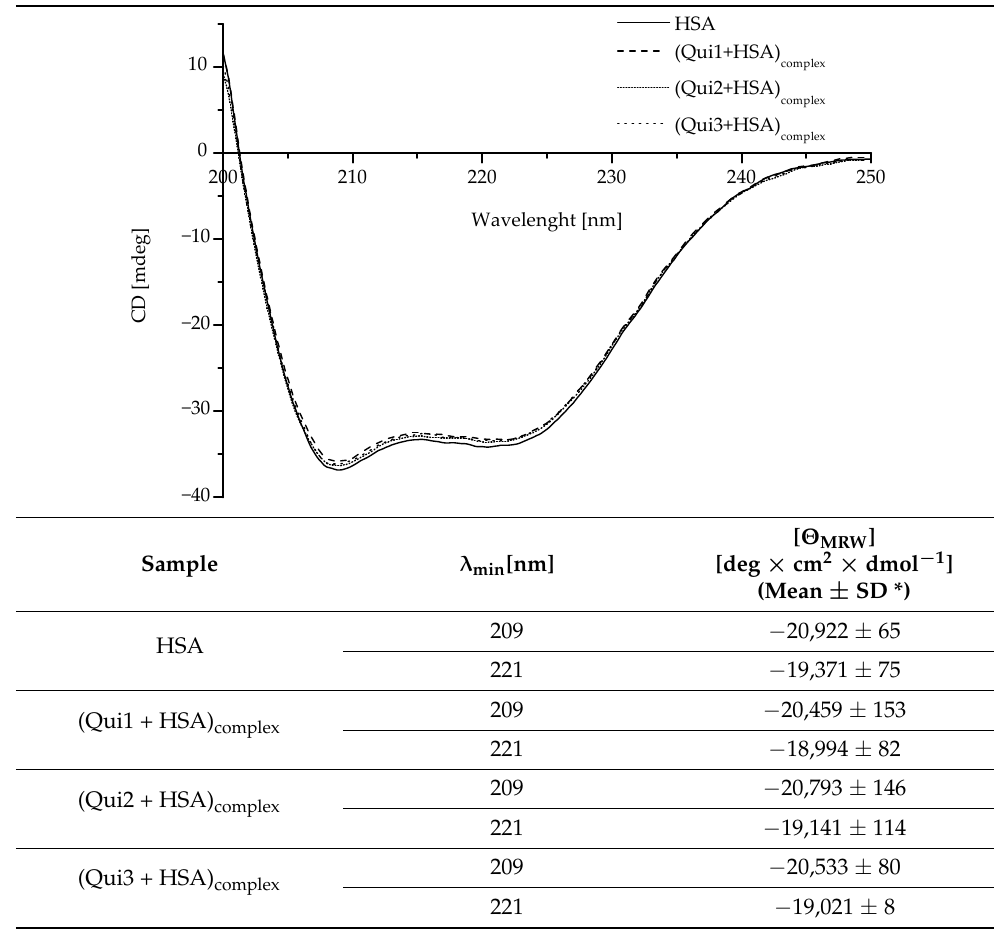
Table 3. The CD spectra and the values of the mean residue ellipticity [ Θ MRW ] of HSA, both in the absence (HSA) and presence of ligands ((Qui1 + HSA) complex , (Qui2 + HSA) complex (Qui3 + HSA) complex ) ([Qui]:[HSA] 2:1 molar ratio)).